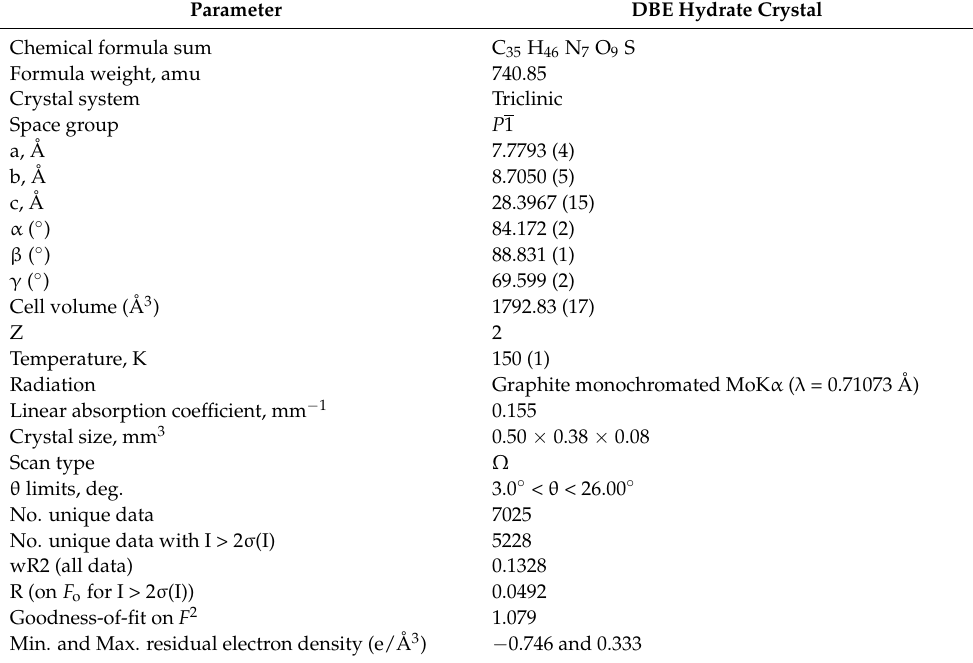
Table 1. Crystal data and structure refinement for DBE monohydrate